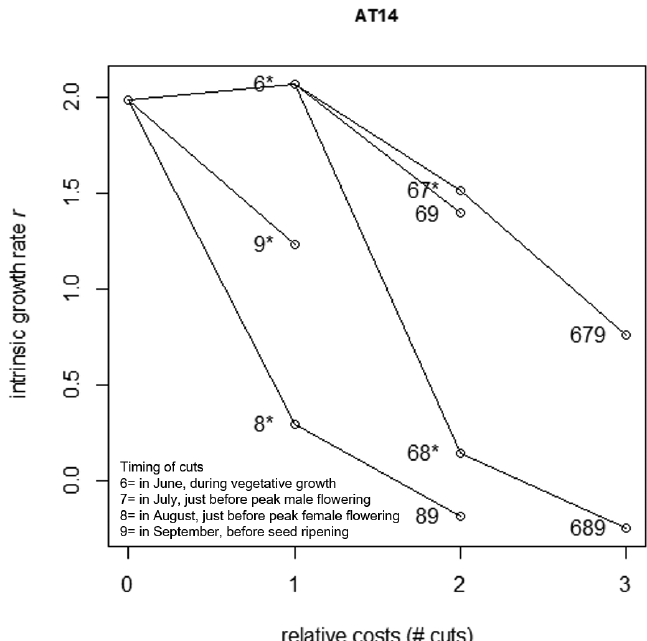
Figure 5. Effect-cost relationships of mowing regimes for the Austrian reference population in 2014 (AT14) for seed survival scenario H. For each mowing regime (dots with labels indicating the months of cutting, see Table 1) and the untreated control (the dot at x = 0), the intrinsic growth rate r (as mean of the 5 years of experimental data) is plotted versus the relative costs of the regime (equalling the number of cuts). Mowing regimes theoretically simulated (by removing or adding the September cut to experimental treatments in the model, see Table 1) are indicated with an asterisk. Lines connect consecutive cuts, show- ing how extending mowing regimes with additional cuts at specific moments alters r